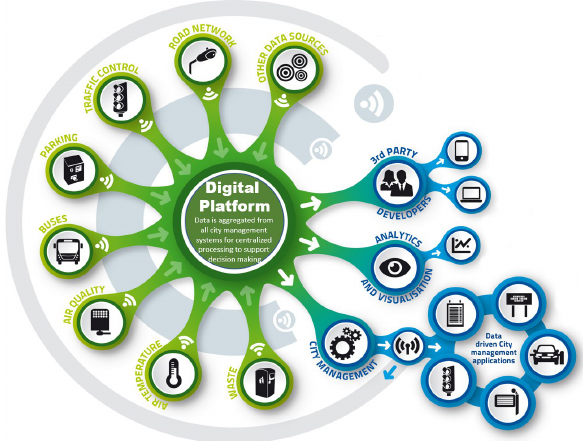
Figure 2 . Smart City